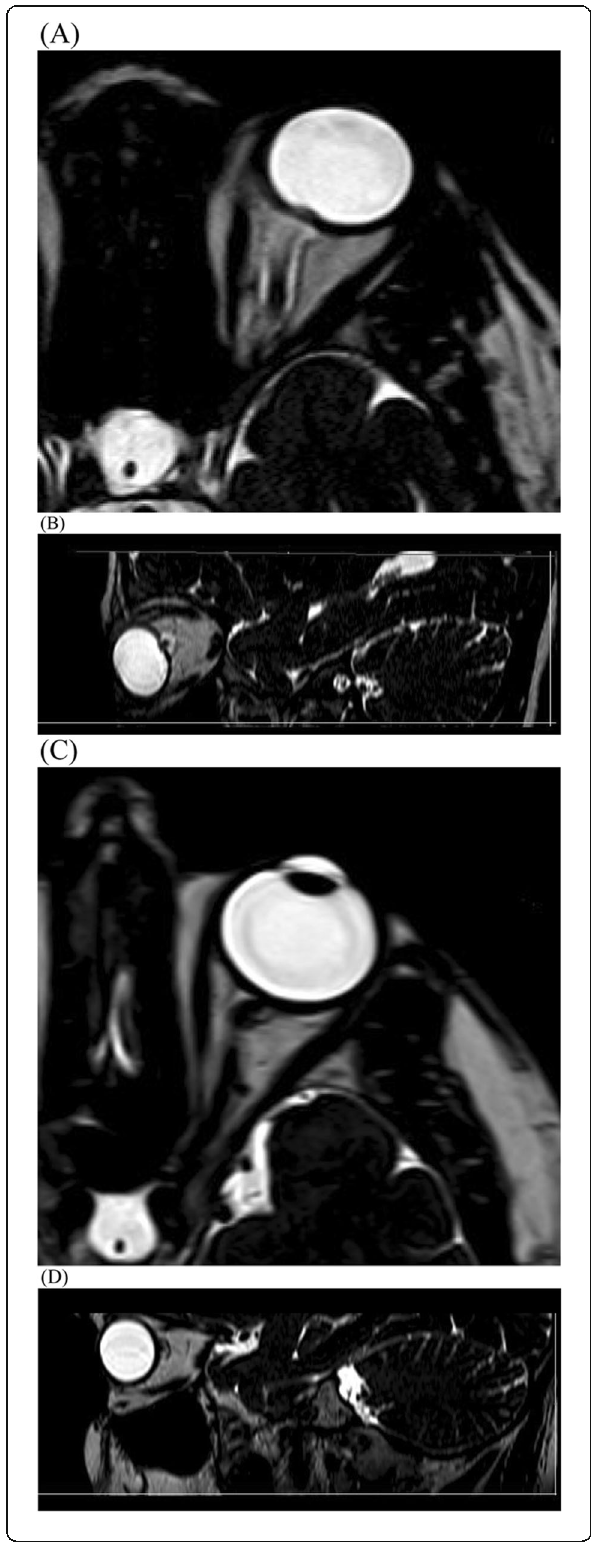
Fig. 3 axial ( a , c ) and sagittal reconstructed ( b , d ) 3D DRIVE sequence in the patient and volunteer of Fig. 2, showing posterior eye globe in the patient ( a , b ) and volunteer ( c , d ). a , b Posterior eye globe flattening and optic nerve head protrusion is seen in